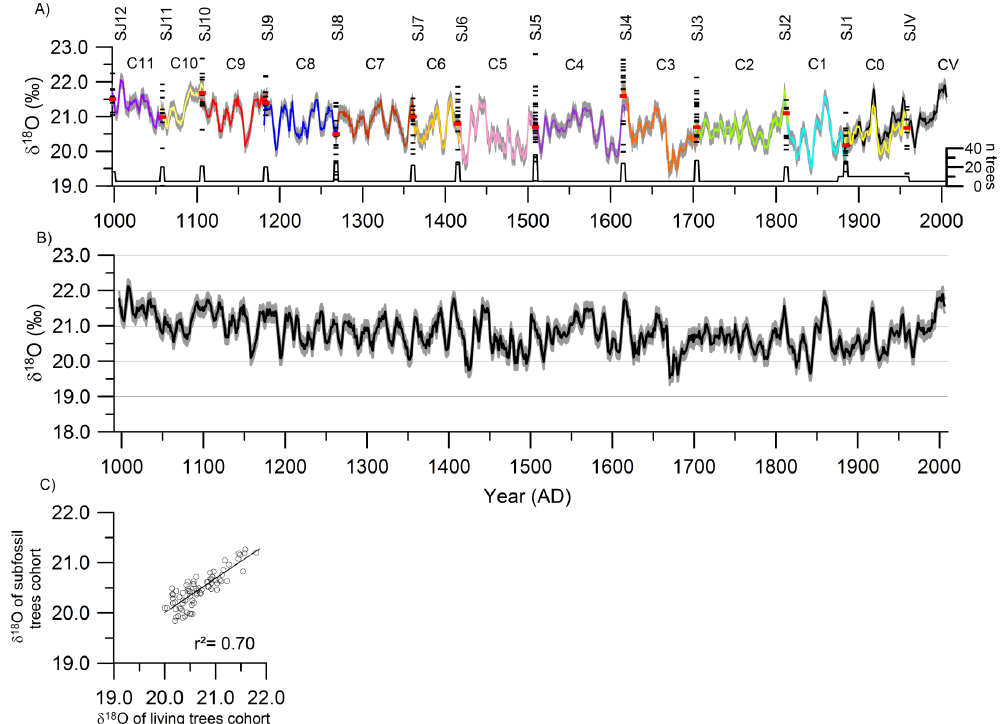
Figure 3. (a) Millennial raw δ 18 O series (1000–2010) with subfossil segment cohorts (cohorts C0 to C11; illustrated with different colors), living tree cohort (CV; dark pink curve), and join points (blue dash), the adjustment means (black dash) and the number of tree segments used per year (straight black line). The gray envelop represents the analytical error (0.2‰). The legend shows the correspondence between the colors curves and cohorts. (b) Millennial δ 18 O series adjusted (black line) with standard deviation (gray lines). (c) Comparison between